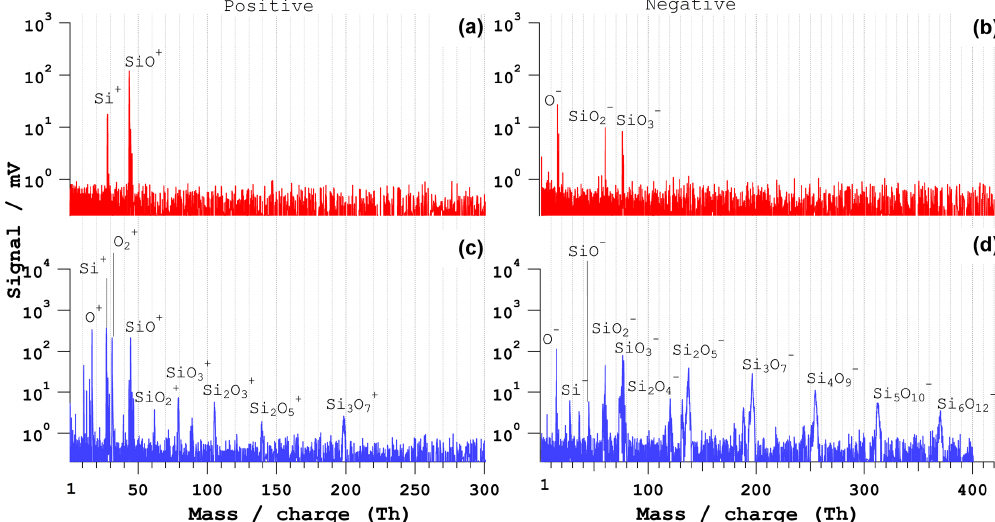
Figure 6. Bipolar mass spectra of SiO 2 single particles of d p = 1100nm. (a, b) Typical ns-laser spectra and (c, d) fs-LAAPTOF ( λ = 800nm) spectra. The pulse energy is 4mJ for the ns laser and 3.2mJ for the fs